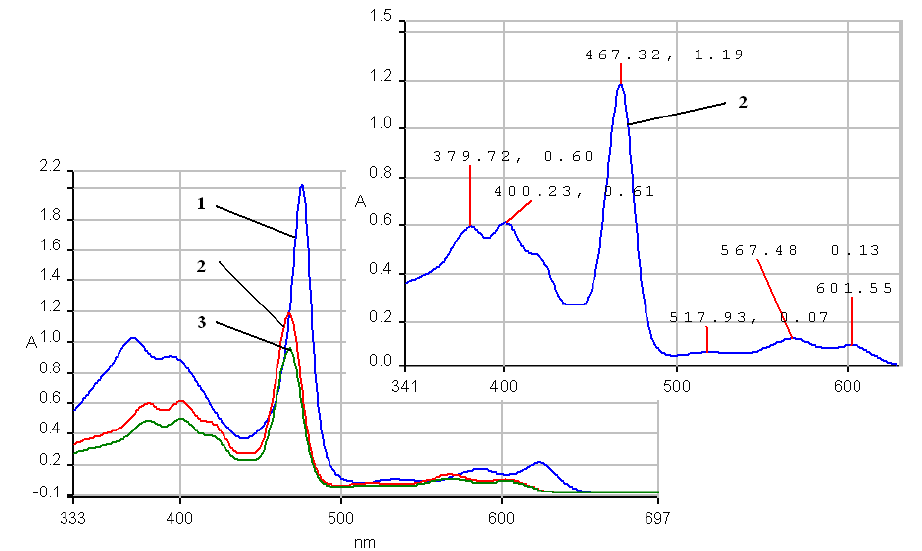
Figure 5. UV-vis spectra. The influence of pH for 2a in a THF/water system. Curve 1: 2a in pure THF; curve 2: pH = 1; curve 3: Mn-porphyrin (µ-oxo-dimer) pH = 6.5; Curve 2 is presented in